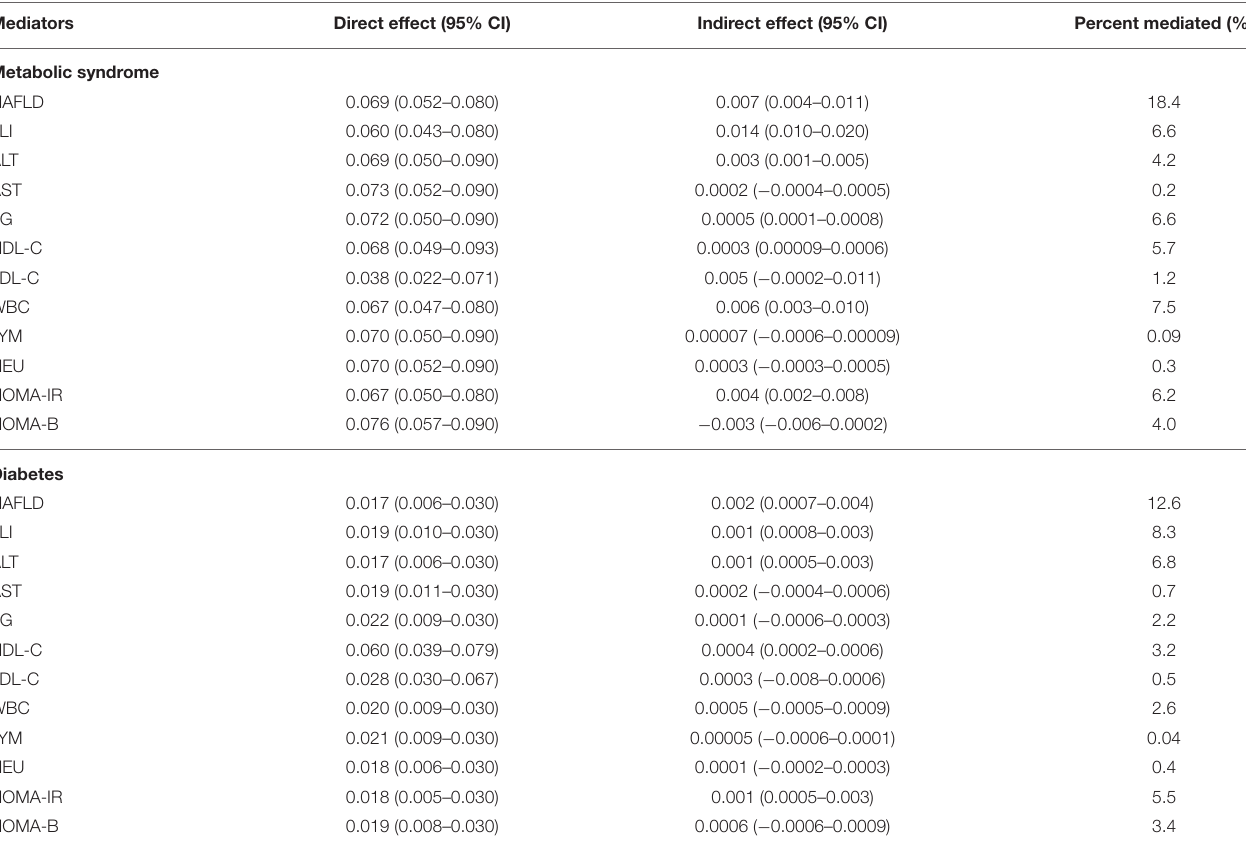
TABLE 3 | Mediation effect investigating potential factors which mediated the association of arterial stiffness with metabolic